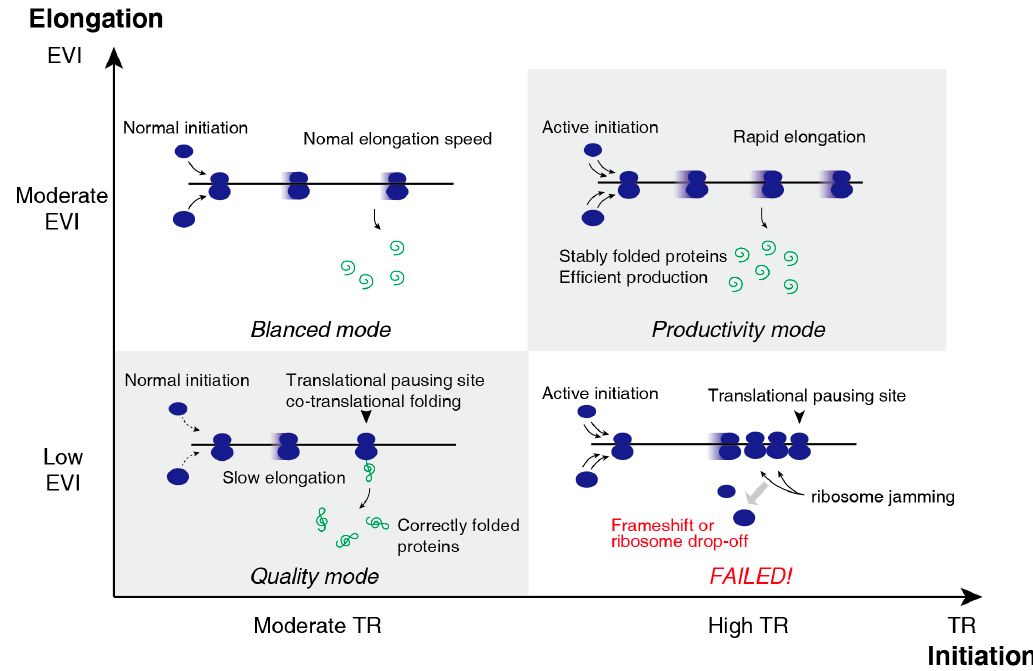
Figure 3. Two-dimensional control mode of translation initiation efficiency (TR) and translation elongation rate (EVI) Most genes are of Balanced mode, with moderate TR and moderate EVI. A small fraction of genes undergoes active translational initiation and rapid elongation and thus are very efficiently produced. These genes under “Productivity mode” do not require co-translational folding for its final conformation; thus, rapid elongation do not impair their functions. Another small fraction of genes is synthesized with moderate TR but low EVI, indicating that there are considerable translational pausing sites along their mRNAs for better co-translational folding quality to ensure their functionality and thus are of “Quality mode.” Simultaneous high TR and low EVI would result in ribosome jamming and thus were eliminated during the evolution.